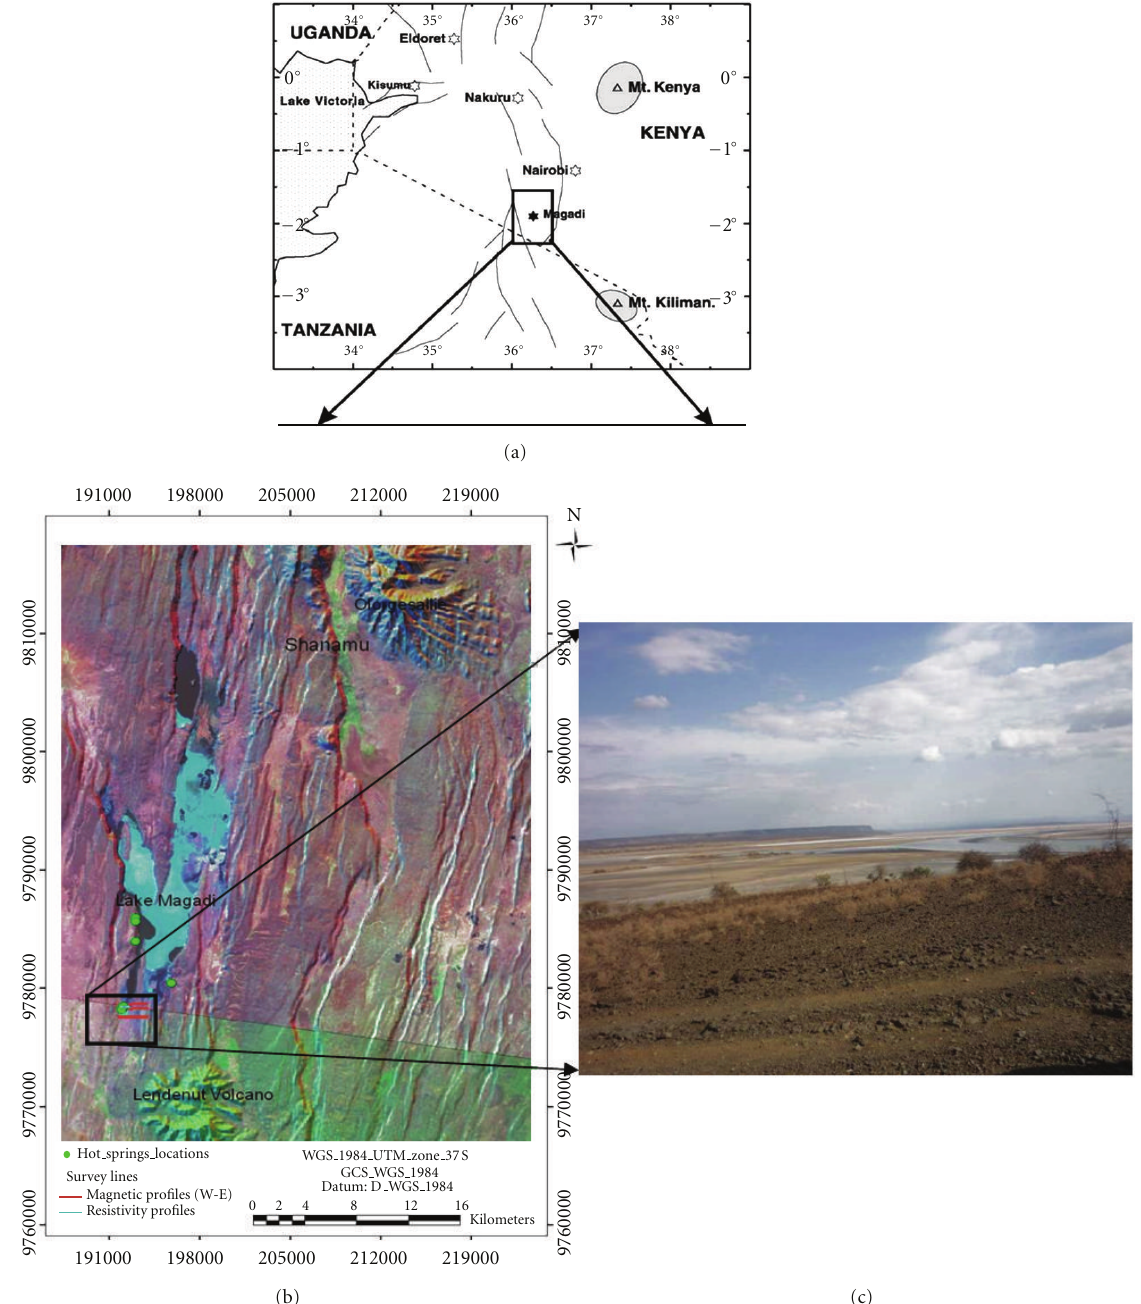
Figure 1: (a) Geographic location of Magadi area after [14], (b) RGB colour composite of ASTER bands 7-3-1 draped over SRTM DEM, showing the study and survey areas, and (c) field photo showing part of the study area and associated